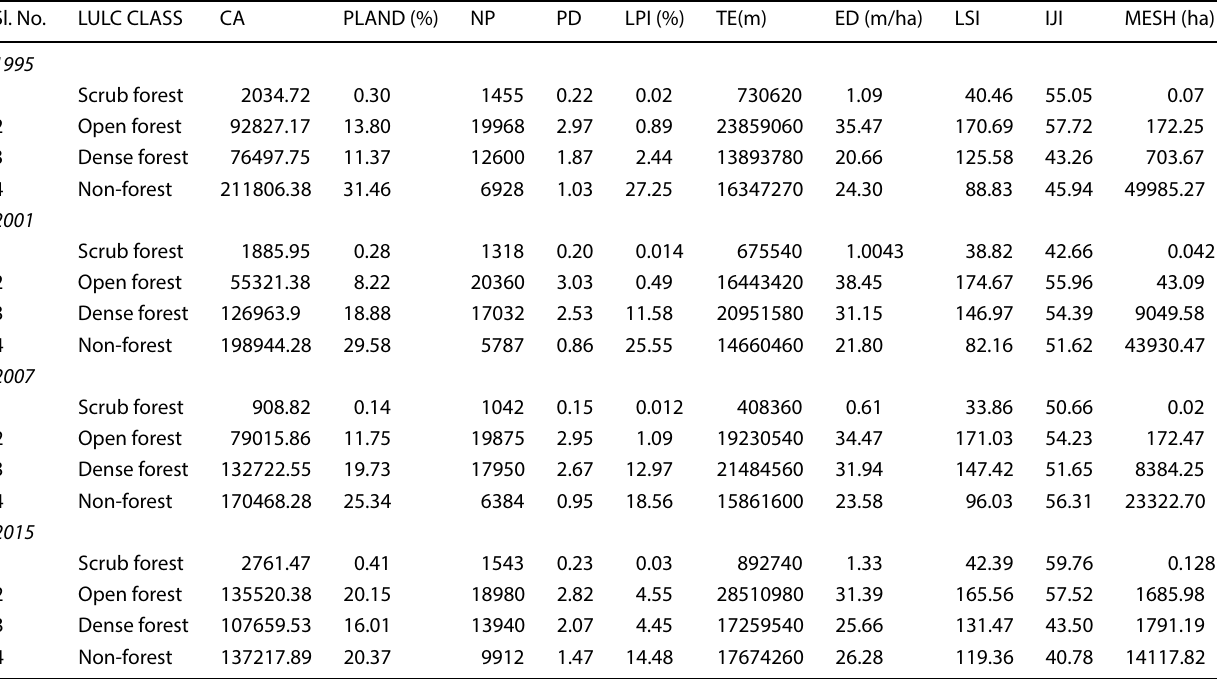
Table 8 Overview of fragmentation in spatial extent of land cover (1995, 2001, 2007, and 2015)